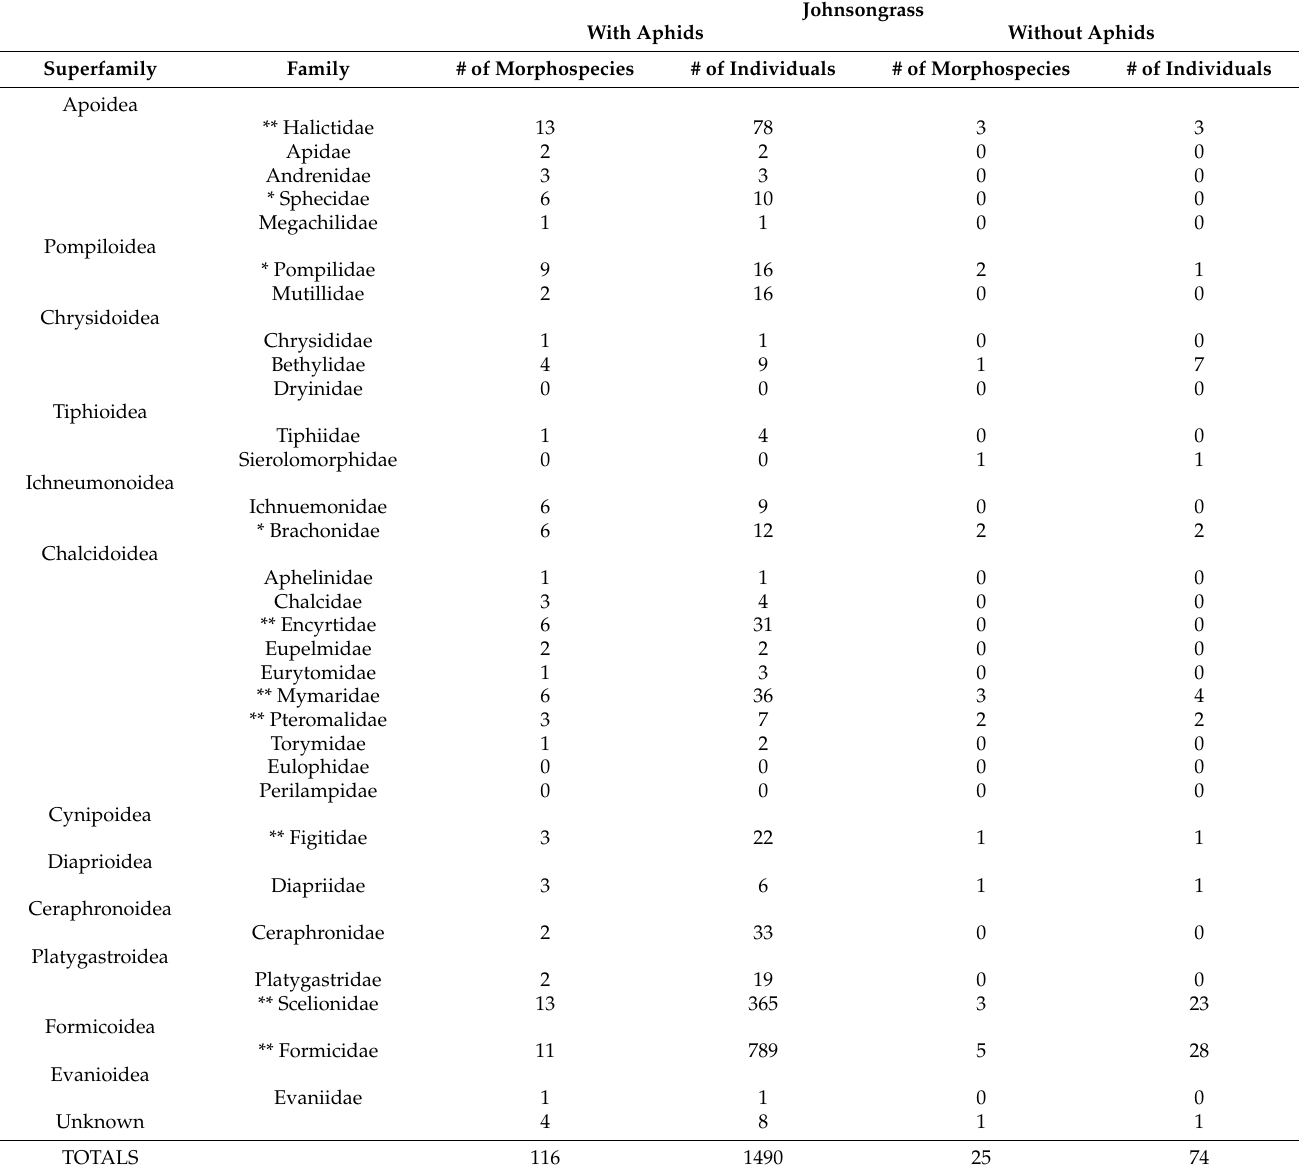
increased the number of ants, halictid bees, and scelionid wasps. Aphids also significantly increased the presence of sphecid, diapriid, mymarid, encyrtid, and braconid wasps, but did not influence the presence of pompilids or mutillids (Table 2). Using pans and sticky traps, 1490 Hymenoptera were collected from Johnsongrass plots with SA and only 74 from uninfested plots. In Johnsongrass, aphids also increased the numbers of ants, halictid bees, braconid, sphecid, encyrtid, mymarid, and scelionid wasps but also increased the number of pompilid and figitid wasps (Table 3). Table 3. Comparison of Hymenoptera families and morphospecies collected in Johnsongrass infested with sorghum aphids and un-infested checks using pan and sticky traps. Johnsongrass With